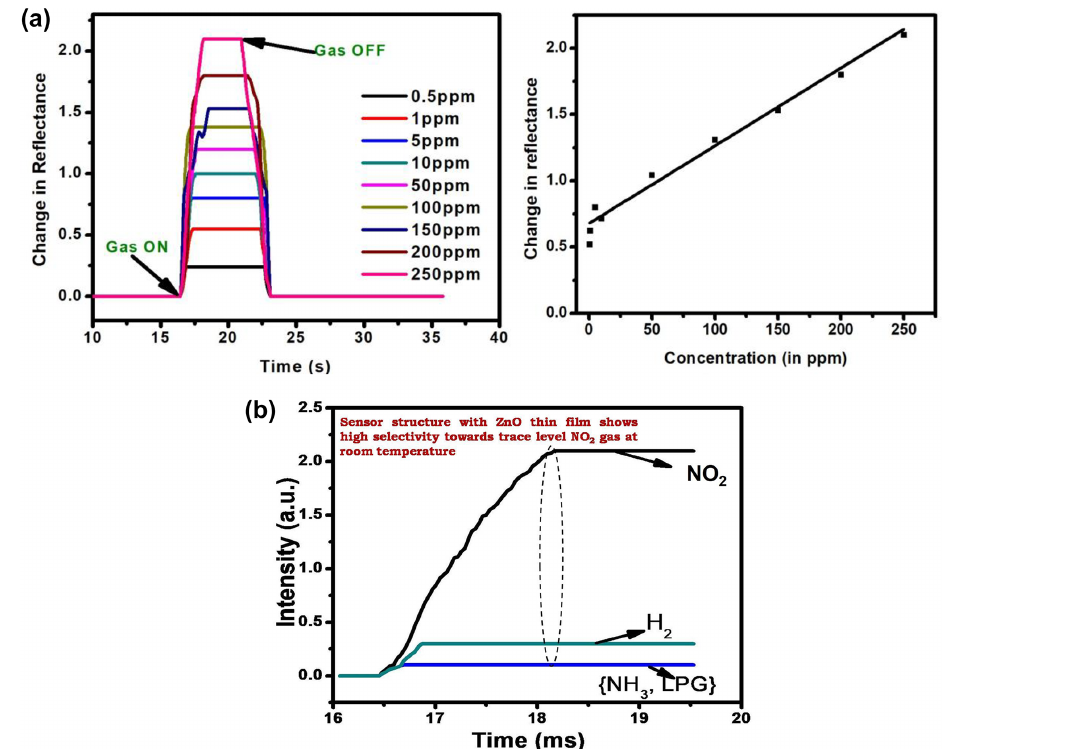
Figure 5. Panel (b) shows the linear variation in the sensing response ( (cid:49)R ) with the concentration of target gas (i.e., calibration curve of the sensor prism / Au / ZnO). The selectivity response of the prepared sensor is shown in Fig. 6, where the gas-sensing response is measured for other harmful gases like NH 3 , LPG, and H 2 of 250ppm